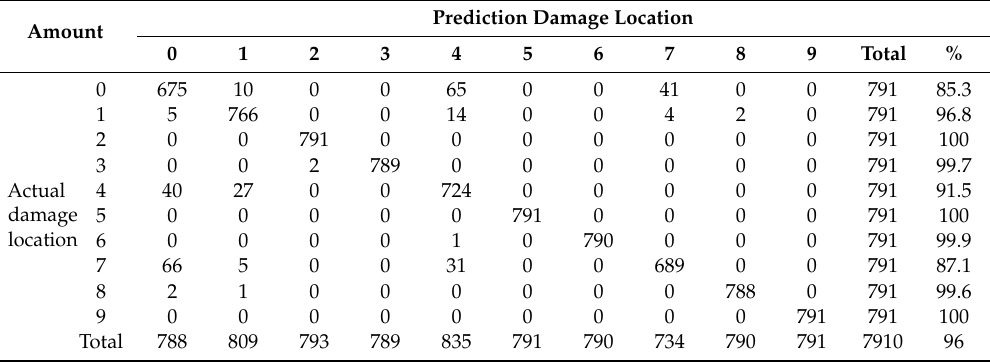
Table 5. Detection results of dataset